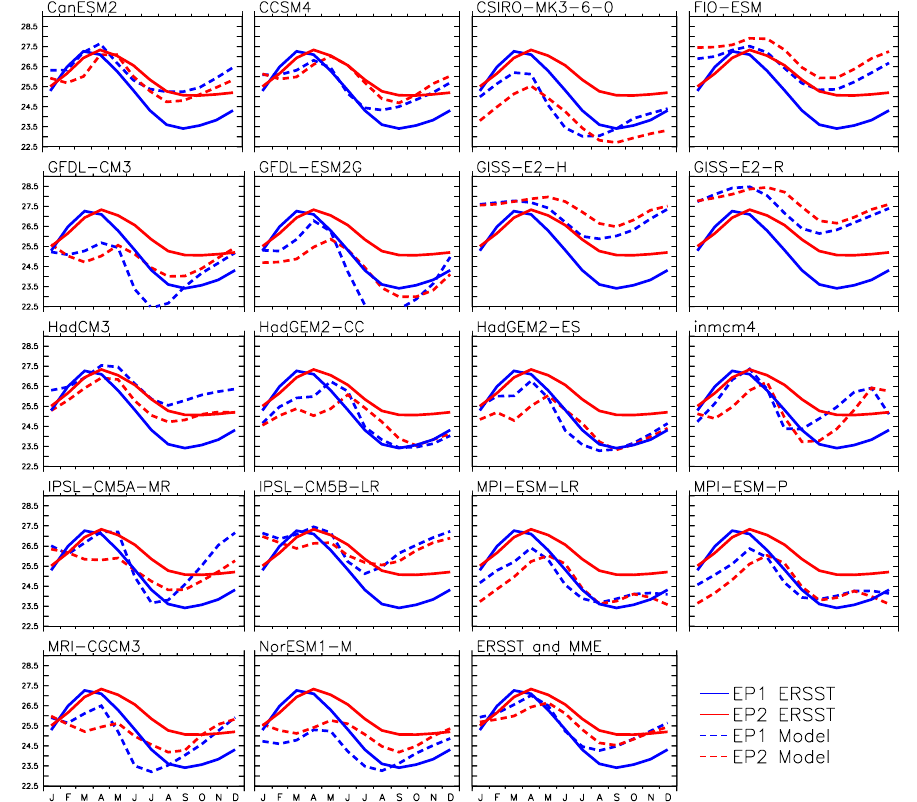
Figure 2. SST seasonal cycles for EEP region 1 (EP1; 110–85 ◦ W, 5 ◦ S–5 ◦ N; blue line) and EEP region 2 (EP2; 140–110 ◦ W, 5 ◦ S–5 ◦ N; red line). The solid curves are the ERSST, and the dashed are model Figure 2 SST seasonal cycles for EEP region 1 (EP1; 110°W–85°W, 5°S–5°N; blue 3 line) and EEP region 2 (EP2; 140°W–110°W, 5°S–5°N; red line). The solid curves 4 are the ERSST, and the dashed are model outputs. 5